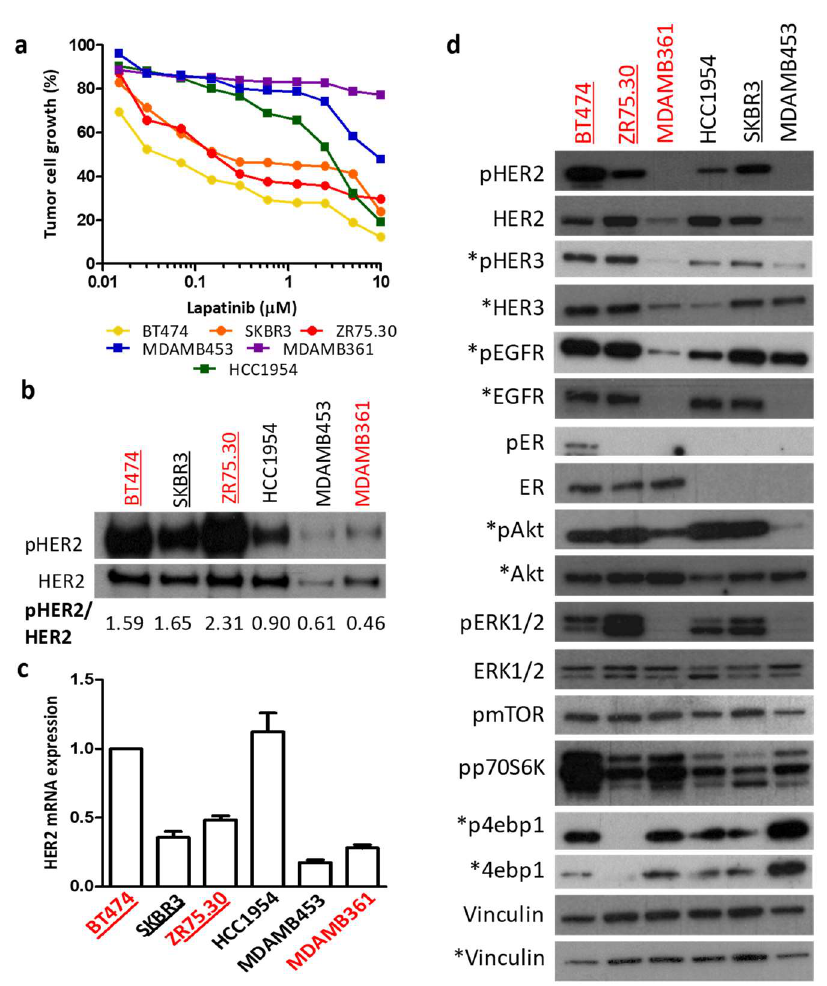
trastuzumab cytotoxic activity ( p = 0.1073, Figure S2a) were higher in HER2-addicted cells than in nonaddicted cells.